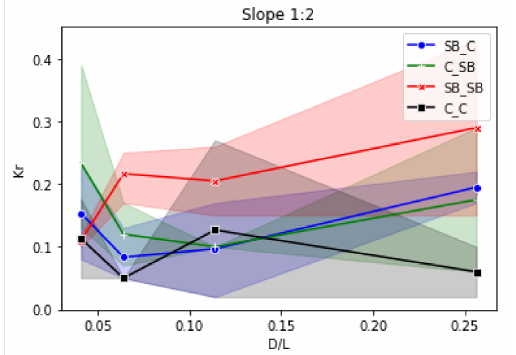
Figure 10. Kr vs. D/L for slope